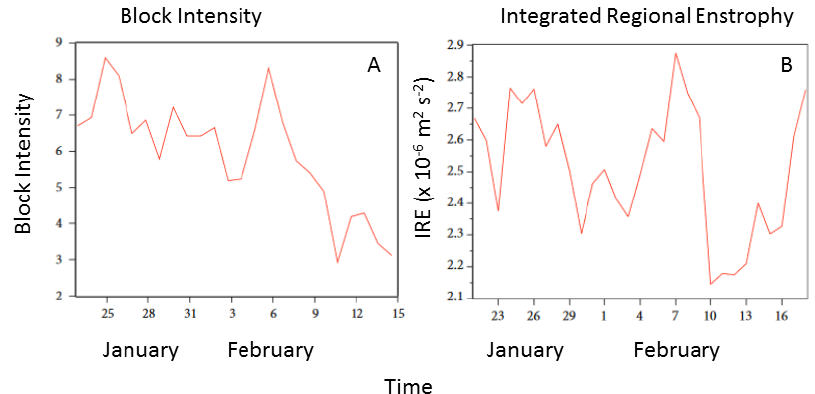
Figure 2. Adapted from [27], ( A ) is the 23 January–15 February Block Intensity (BI) from [30] (ordinate) for the event studied in winter 2013–2014 versus date in January and February 2014 (abscissa); and ( B ) the IRE (m 2 ·s − 2 ) (ordinate) from 21 January–18 February (abscissa). Table 1. Value calculated for the IRE diagnostic ([23]) and for estimating the right-hand side (RHS) of the inequality in Equation (5).